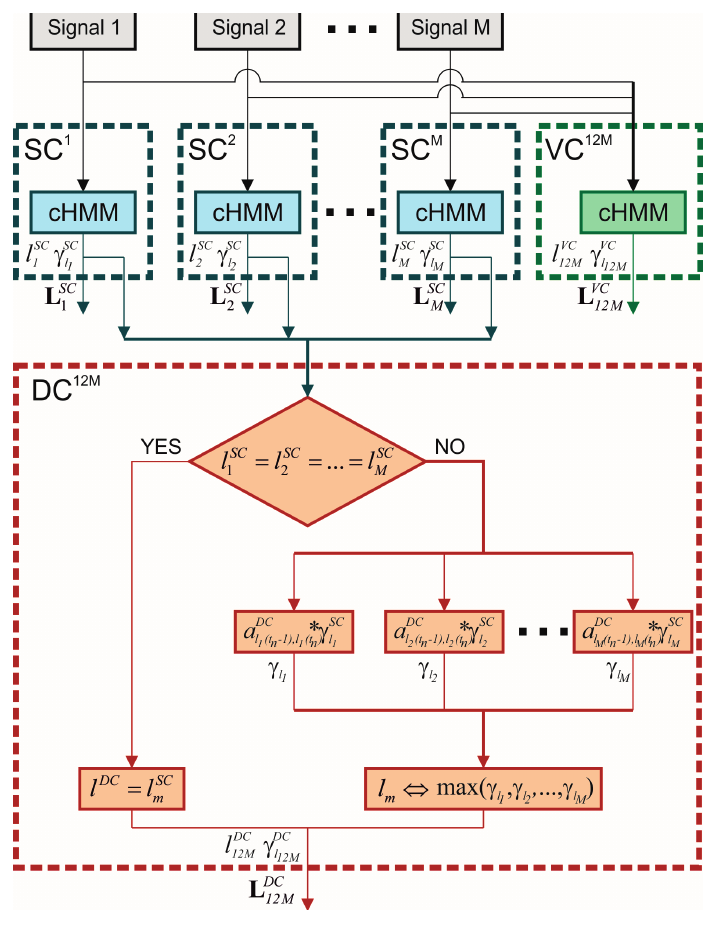
Figure 2. Logical diagram of Scalar Classifier SC, Vectorial Classifier VC and Distributed Classifier